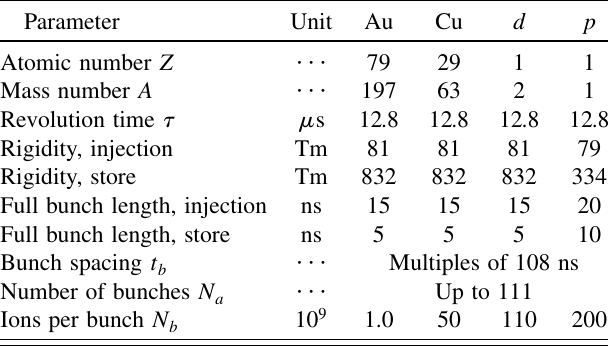
TABLE I. Main machine and beam parameters relevant to electron clouds for all species RHIC has operated with